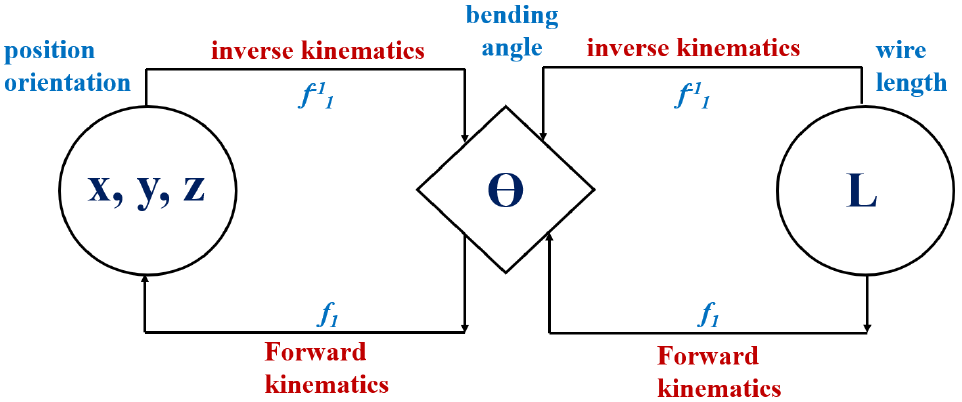
Figure 3. Kinematics relationships of the location, direction, and length changes.